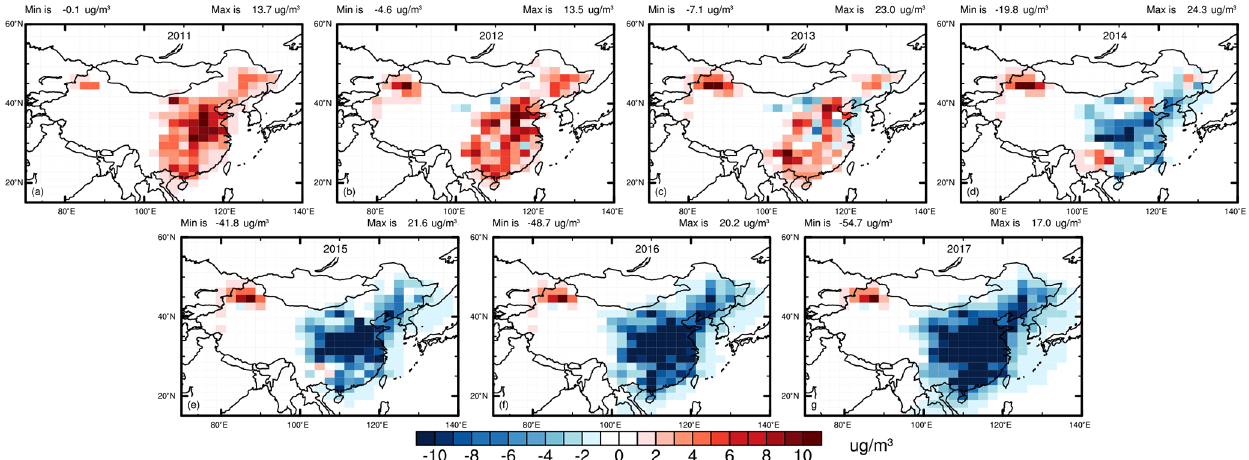
Figure 2. Annual PM 2 . 5 changes (unit of µgm − 3 ) from 2011 to 2017 due to anthropogenic emission changes in China only. The results are calculated as the differences between CEDS_MEIC and CEDS_MEIC_ChinaFix for each